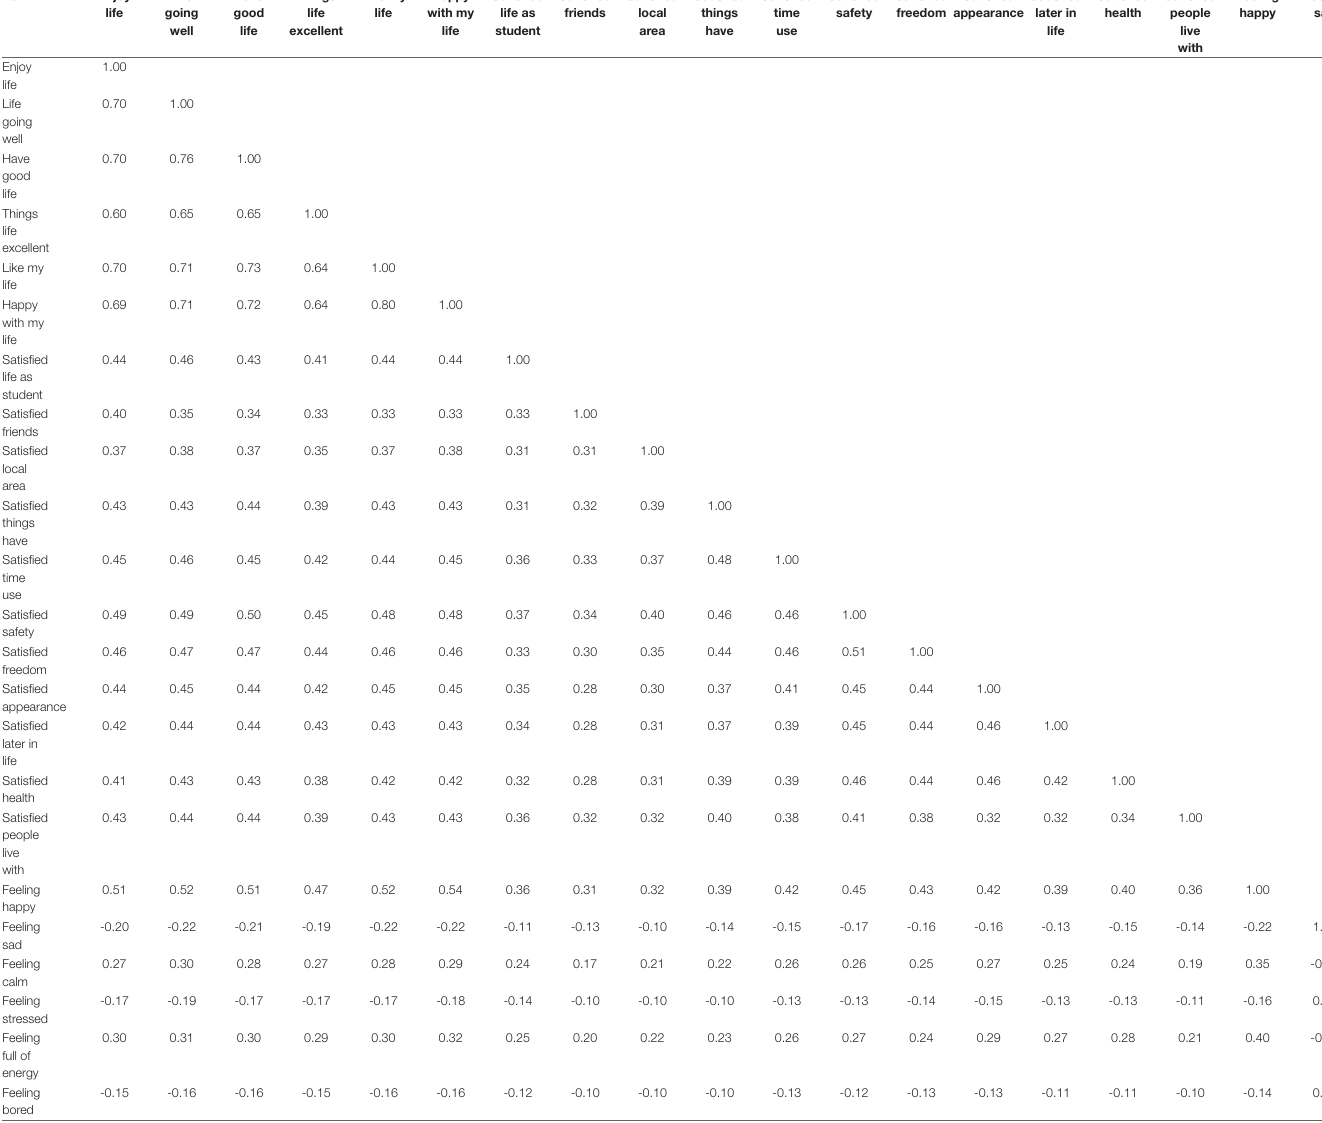
TABLE 2 | Correlation matrix for items on the scales.